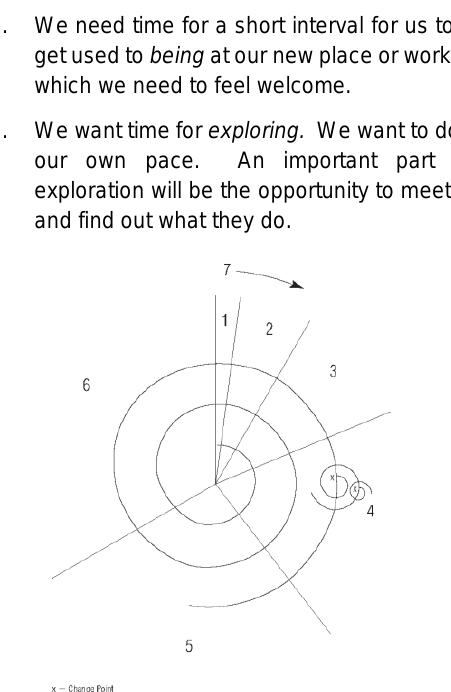
Figure 9: Spirals within Spirals (Hay, 2012, p.206) (Note that I draw the stages proportionally to represent the time spent in them rather than dividing them equally as Levin had done)